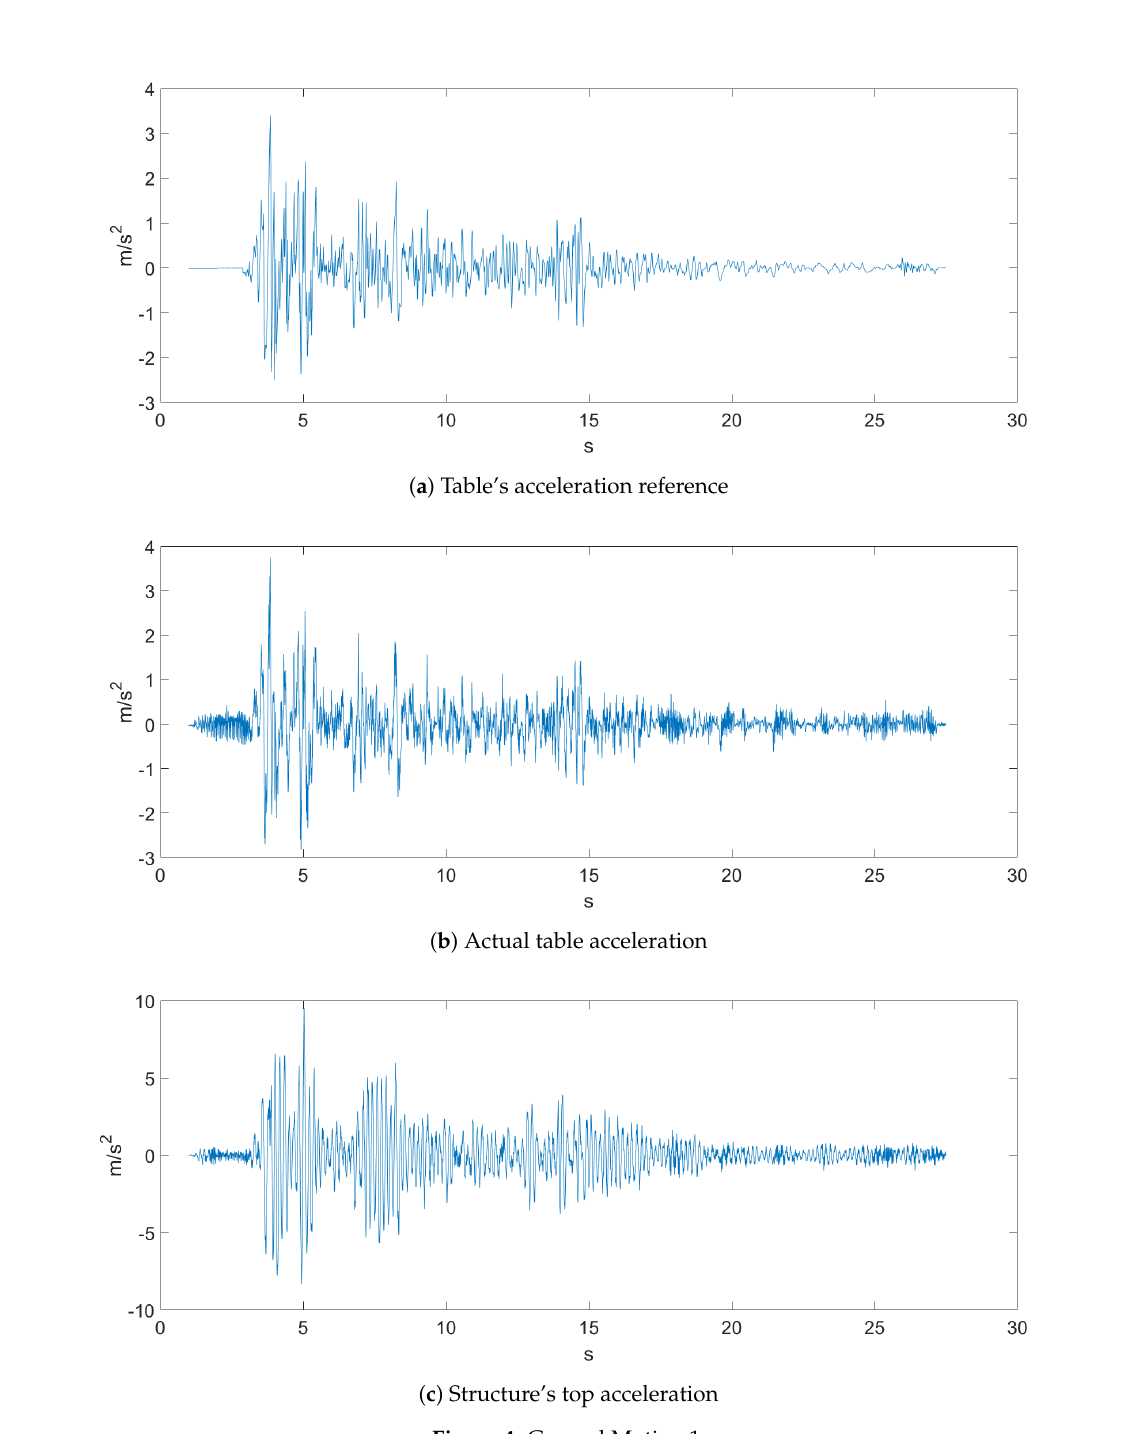
Figure 4. Ground Motion